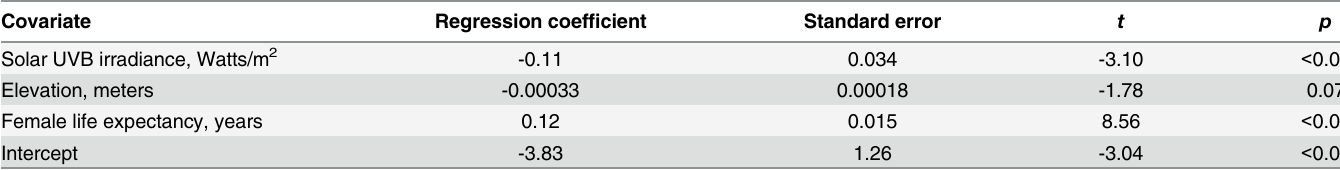
Table 3. Multiple linear regression model for age-standardized leukemia incidence rates according to cloud-adjusted UVB irradiance, females, 158 countries, 2012 ( R 2 = 0.58; p <